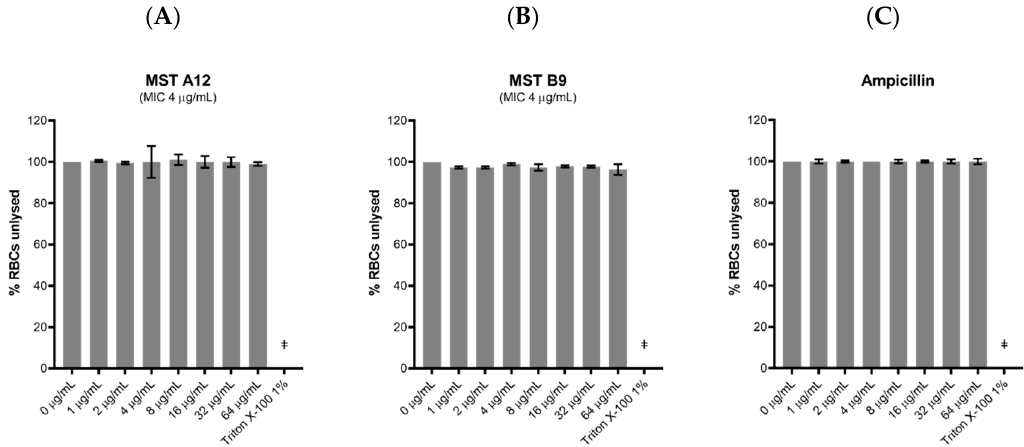
Figure 9. The MST compounds display no haemolytic activity. Freshly washed human RBCs in fresh PBS solution (137 mM NaCl, 2.7 mM KCl, 1.46 mM KH 2 PO 4 , 8.1 mM NaH 2 PO 4 , pH 7.4) were exposed to 2 µL MST compounds with concentrations ranging from 0 to 64 µg/mL in 1% ( v / v ) DMSO. A 1% ( v / v ) Triton X-100 solution was used to indicate complete RBC lysis ( ǂ ). Two compounds A12 ( A ) and B9 ( B ) are shown as examples to illustrate this effect. Ampicillin (0–64 µg/mL) was used as example of drug that does not cause RBC lysis ( C ). The assays were performed in quadruplicates. The plates were incubated at 37 °C while constantly shaking at 100 rpm for 1 h. Intact RBCs were removed by centrifugation and the presence of haemolytic products in the supernatant was determined by measuring the absorbance at A 450 nm. The results are presented as the mean ± SEM. Statistical analysis was performed using a one-way ANOVA and indicated no statistically significant change in RBC lysis ( p > 0.05).